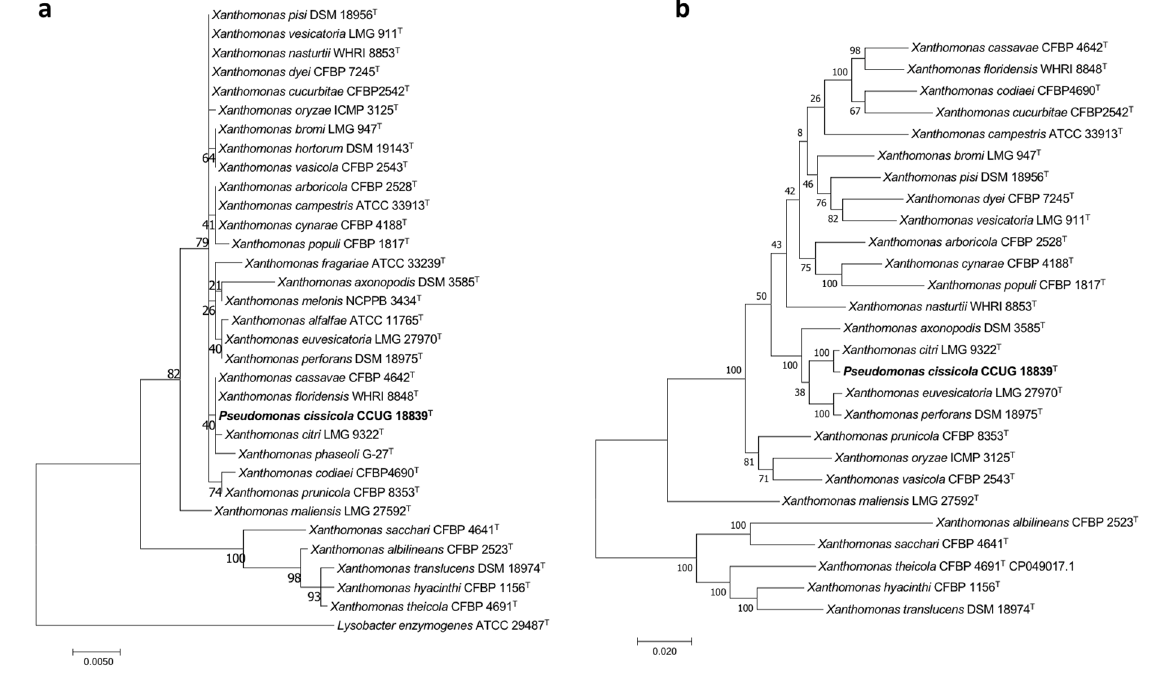
Figure 5. Phylogenetic trees built to study the taxonomic placement of P. cissicola CCUG 18839 T based on ( a ) the 16S rRNA gene ( b ) 16S rRNA, gyrB , rpoD , dnaK and fyuA concatenated genes. Scale bars = 1 nucleotide (nt) substitution per 100 nt.